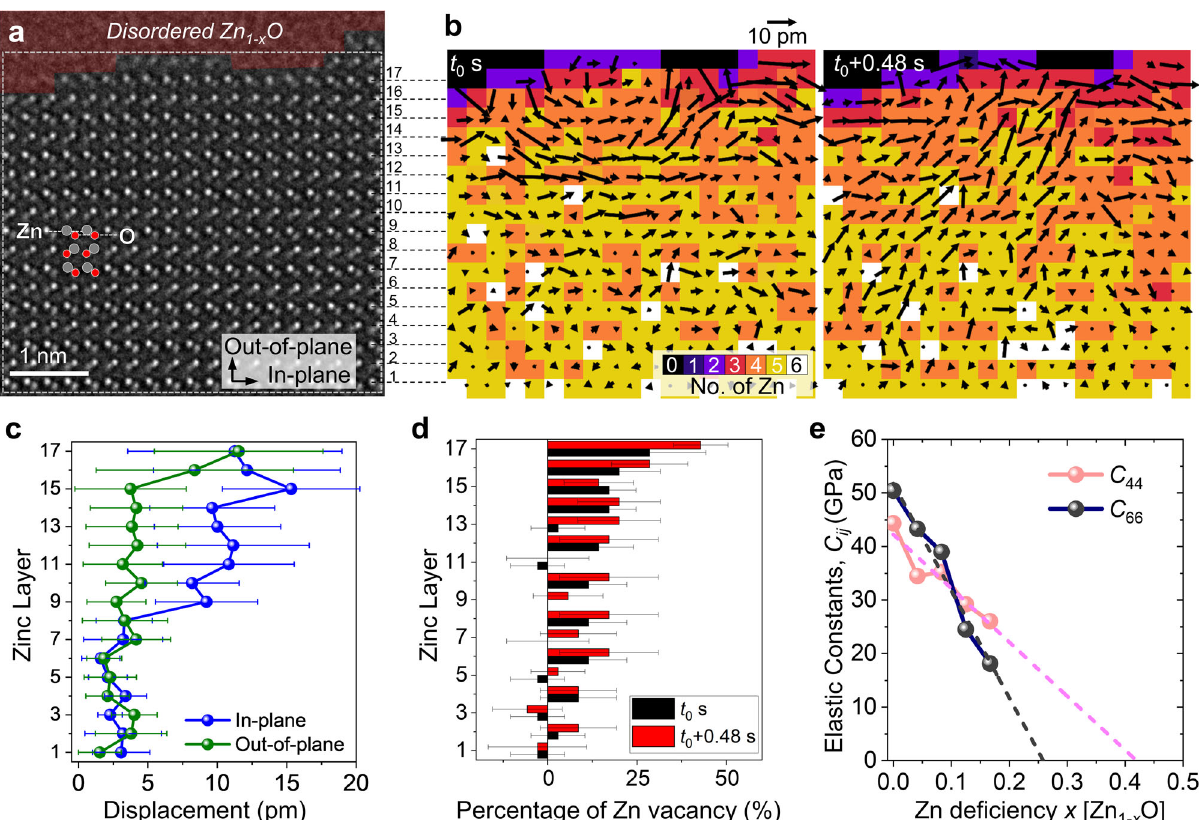
Fig.4|V Zn diffusioninducedlatticedynamicsandinstabilityofsubsurfaceZn 1- x O during evaporation. a In-situ NCSI-HRTEM snapshot image of ZnO during anisotropic dissociative evaporation from the ZnO (0001) polar surface at 300°C. Thequasi-liquidlayerformedonthe(0001)surfaceishighlightedinred.Brightand dim atomic columns correspond to Zn and O columns, respectively. The Zn layers are numbered from the bulk to the surface. b Time series displacement vector (blackarrow)andatomcountmaps(coloredpixels)ofZncolumns.Theinitialtime of measurement is de fi ned as t 0 . The number of Zn atoms in each column was determined by quantitative analysis of the Zn column intensities (Supplementary Fig. 11). The majority of Zn columns (yellow pixels) contains fi ve Zn atoms. The reference positions for displacement map were the averaged positions over selected time spans. The magnitude of vector is multiplied by 30 times for better visualization. A high degree of correlation between V Zn and displacement of Zn column is found; the Zn columns containing less Zn atoms, equivalently more V Zn , exhibit large displacement in the subsurface region (Supplementary Movie